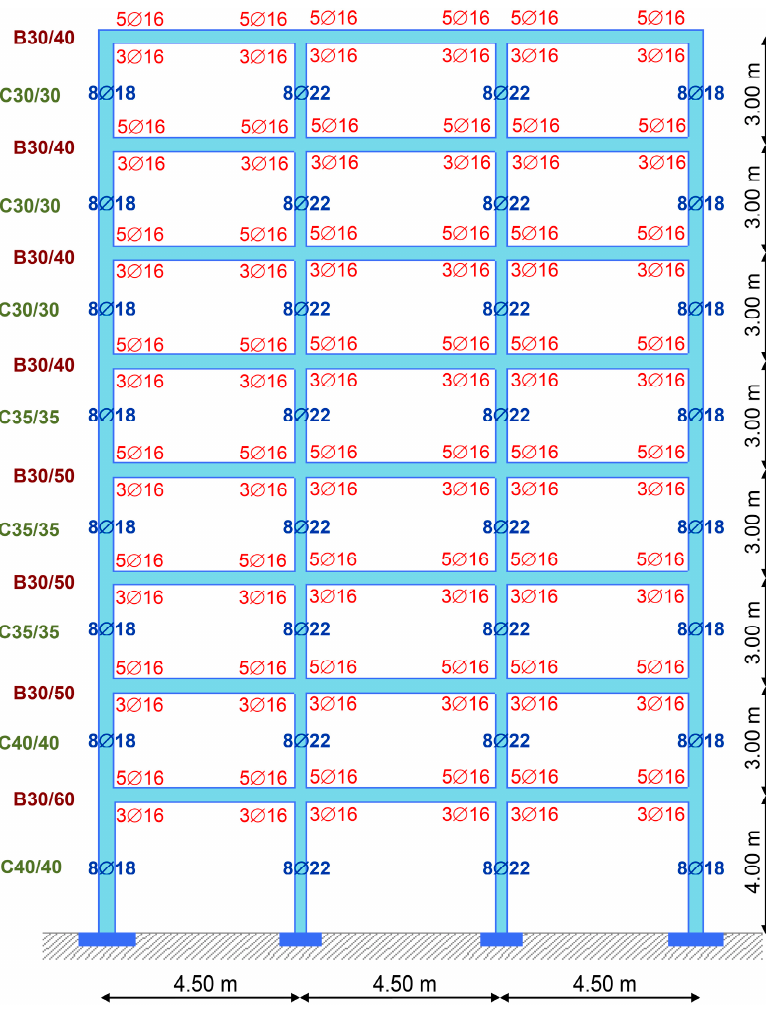
Figure 6. Frame A3 properties.